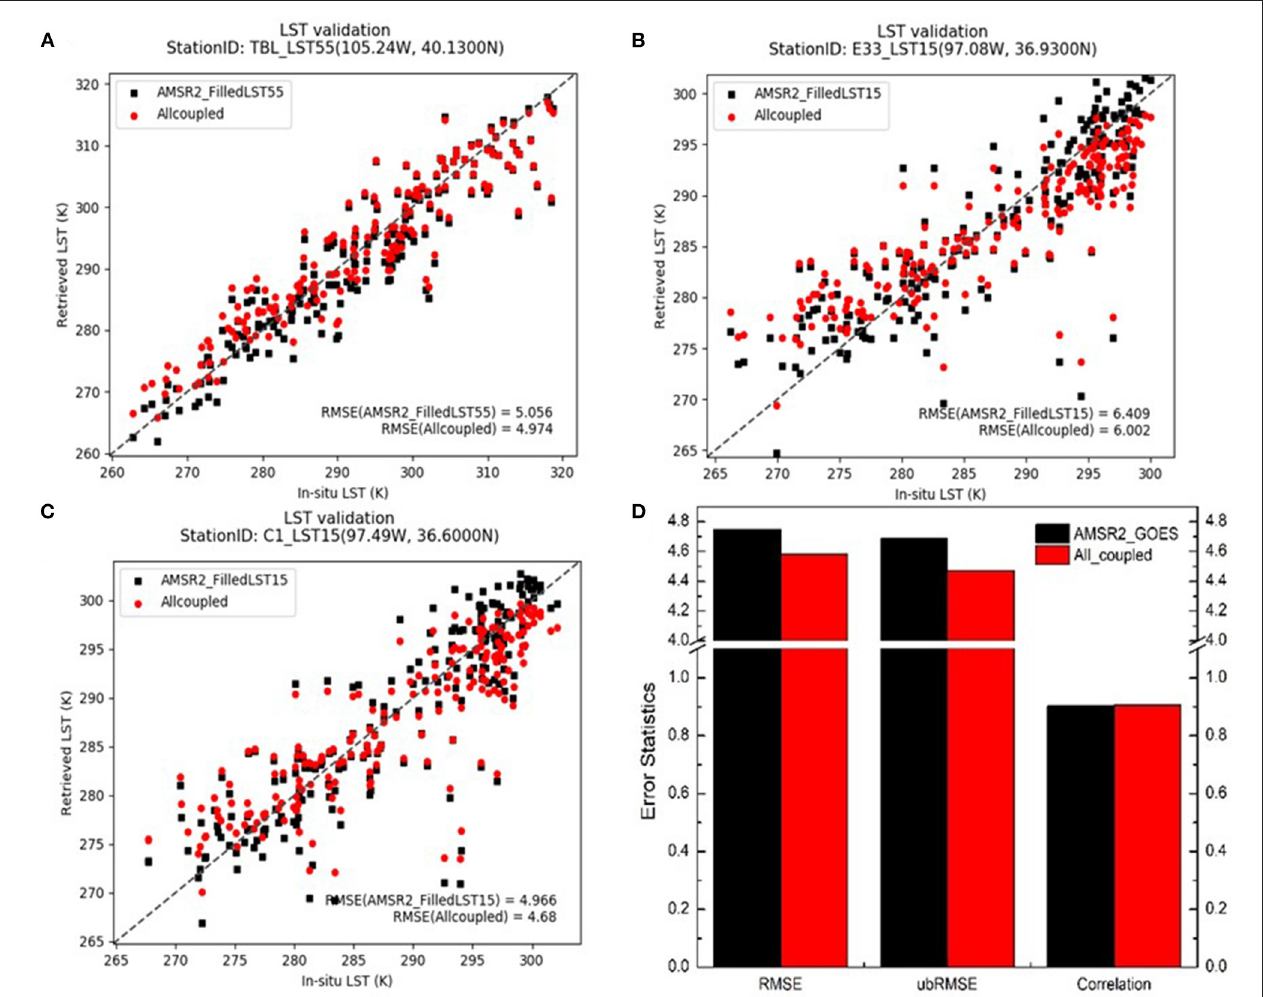
FIGURE 4 | Validation of machine-learning-derived LSTs against in-situ LST measurements over the period from Jan. 26 to Dec. 31, 2018; (A–C) scatter plots of LSTs derived from MW/TIR (black) compared with those from MW/TIR/LSM (red) over three sample stations; (D) overall error statistics averaged from all validation